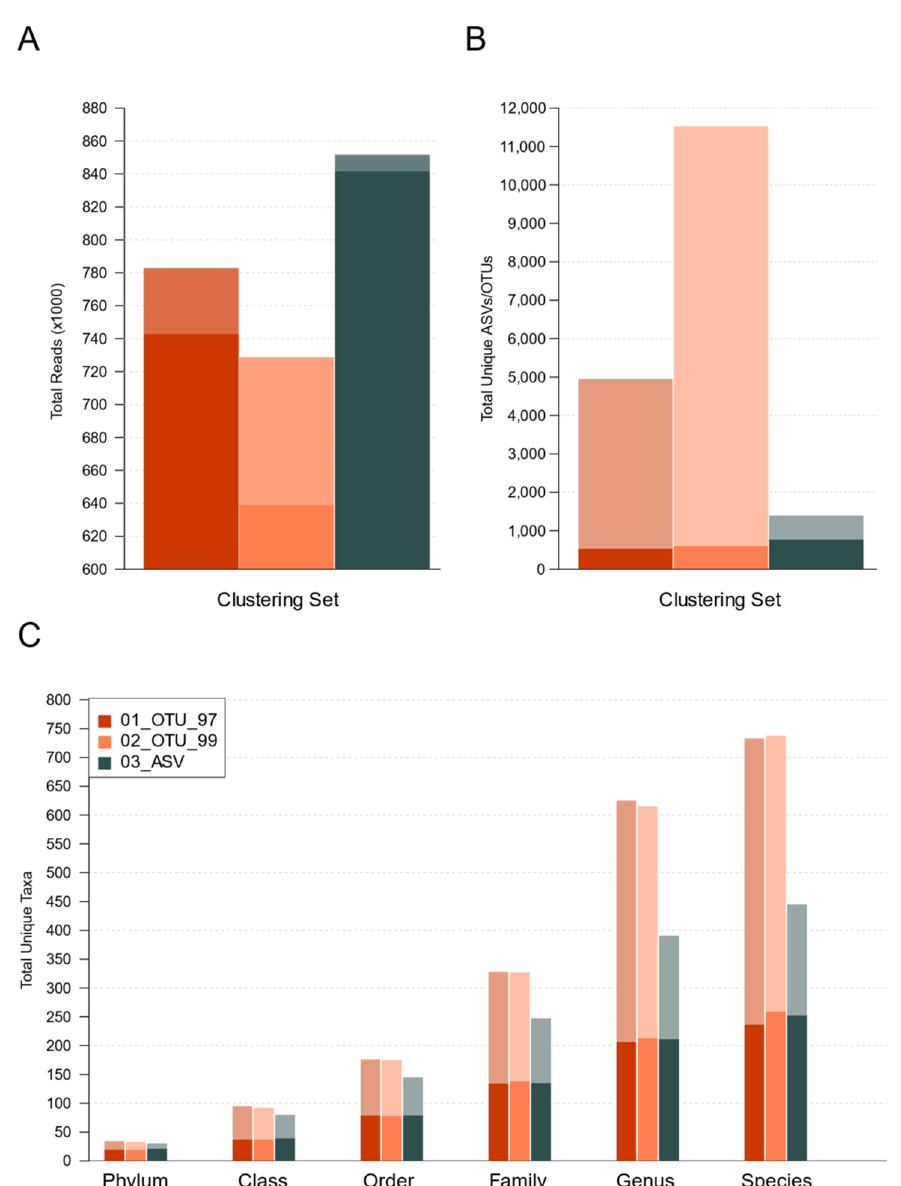
Figure 3. Impact of abundance filters on different performance parameters for each methodological set. Light-colored bars show the original raw totals, just after the removal of singletons and chimeras. Dark-colored bars show items remaining after abundance filters. ( A ) Total reads per set. ( B ) Total unique clusters (OTUs/ASVs) per set. ( C ) Total unique taxa per level and set.